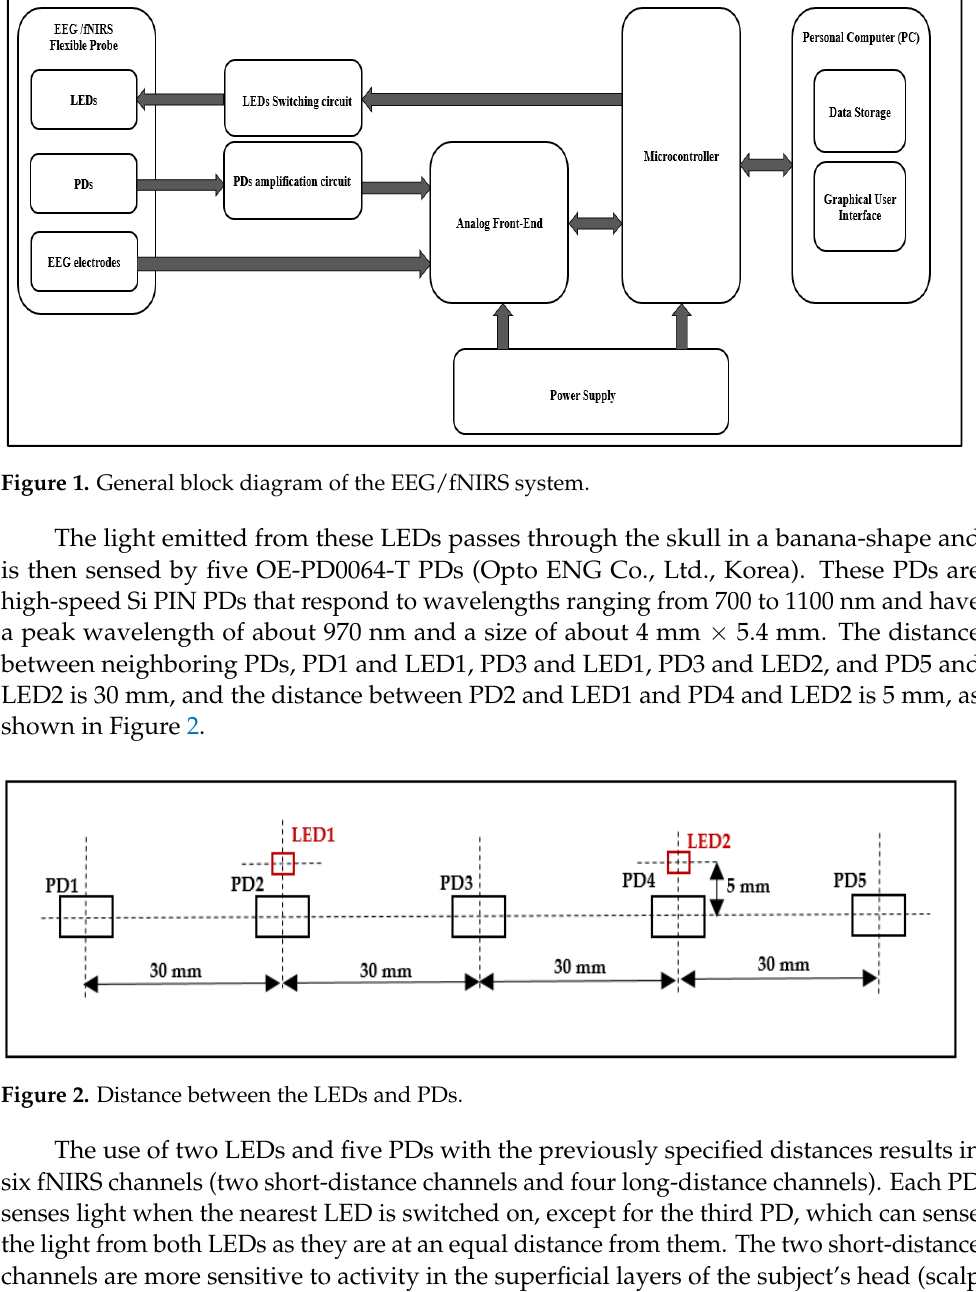
( c ) Figure 3. ( a ) Flexible EEG/fNIRS probe, ( b ) 4 mm buckle, ( c ) micro HDMI FPC flat cable. 3.1.2. Light-Emitting Diodes (LEDs) Switching Circuit This circuit is responsible for turning LEDs on and off. At the beginning, LED1 is turned on to emit light with a wavelength of 735 nm, then turned off. After that it is turned